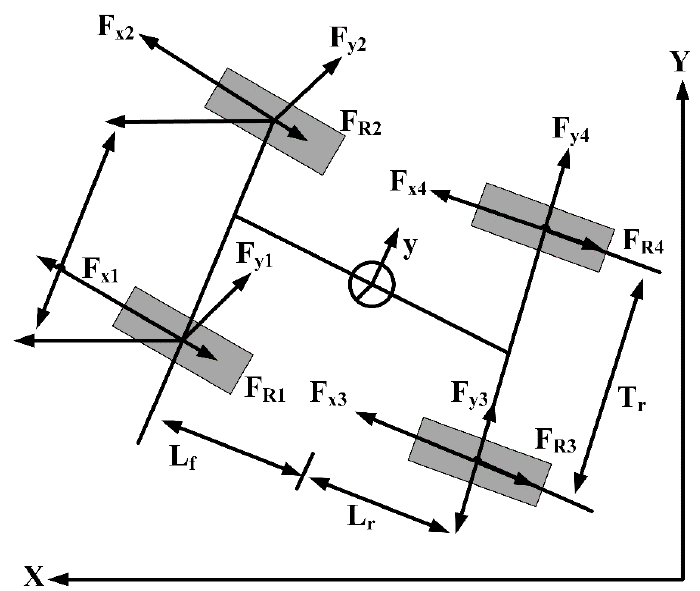
Figure 65. Forces acting on the wheels of a car. Each of the wheels experience forces in all three directions, marked with the ‘F’ vectors. L f and L r show the distances of front and rear axles from the center of the vehicle, while T r shows the distance between the wheels of an axle. Adapted from [25].